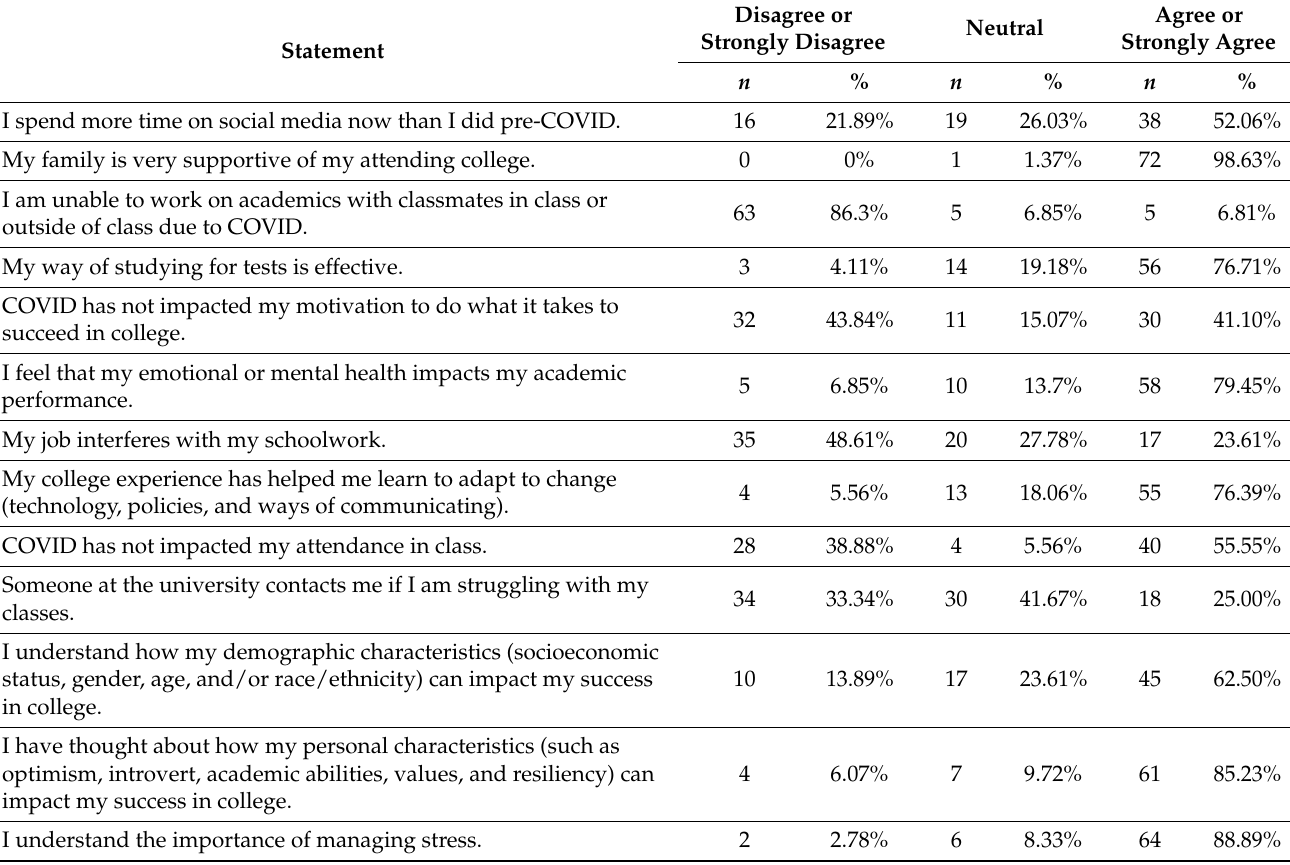
Table 4. Perceptions of Factors Impacting